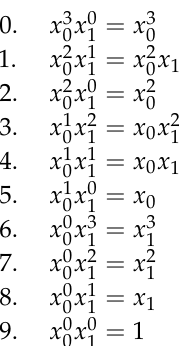
is sorted by the enumeration of monomials g